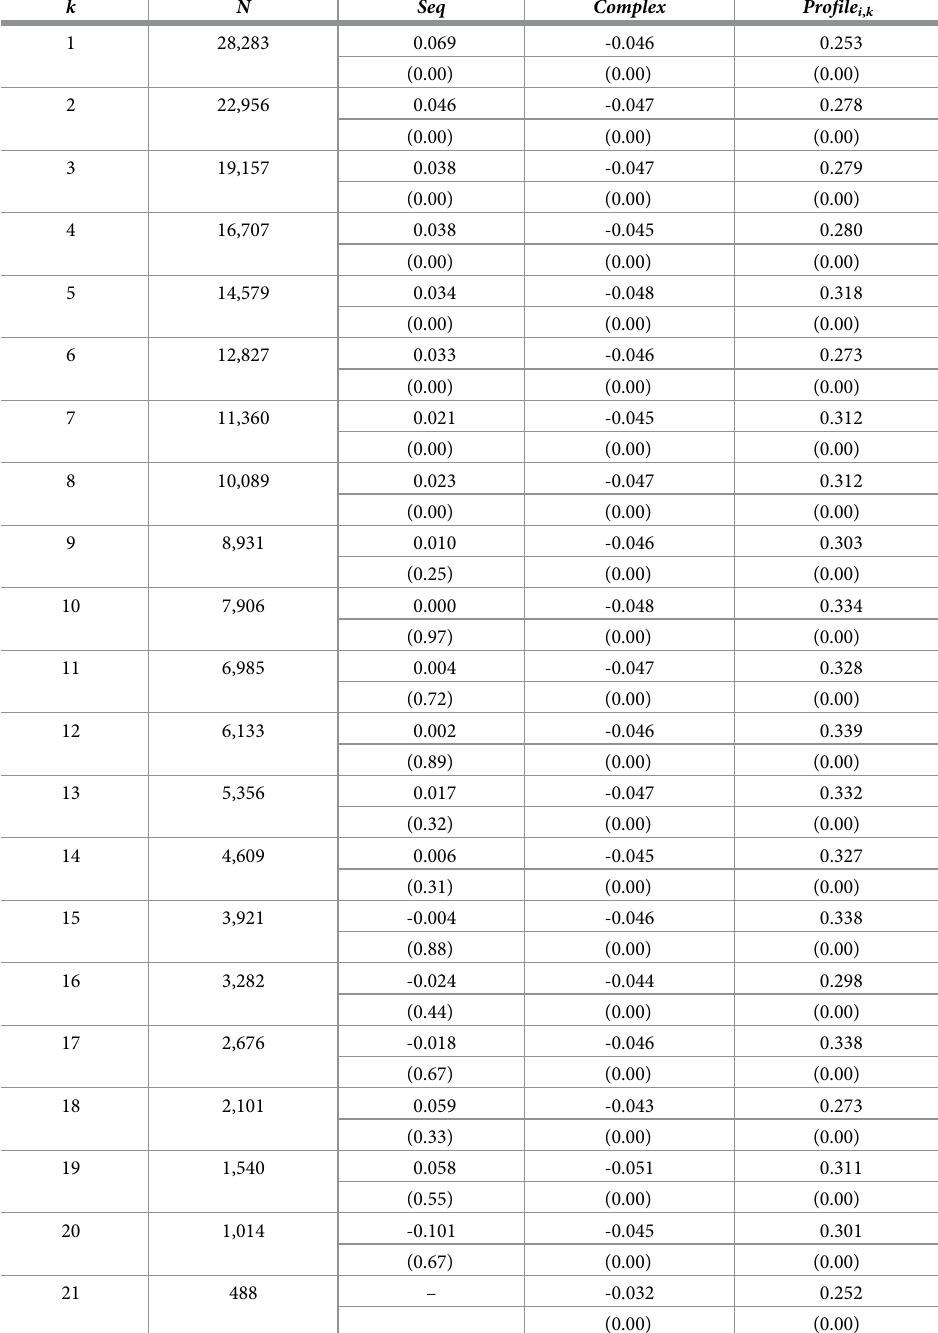
Table 4. Predictive power of a profile constructed from a single